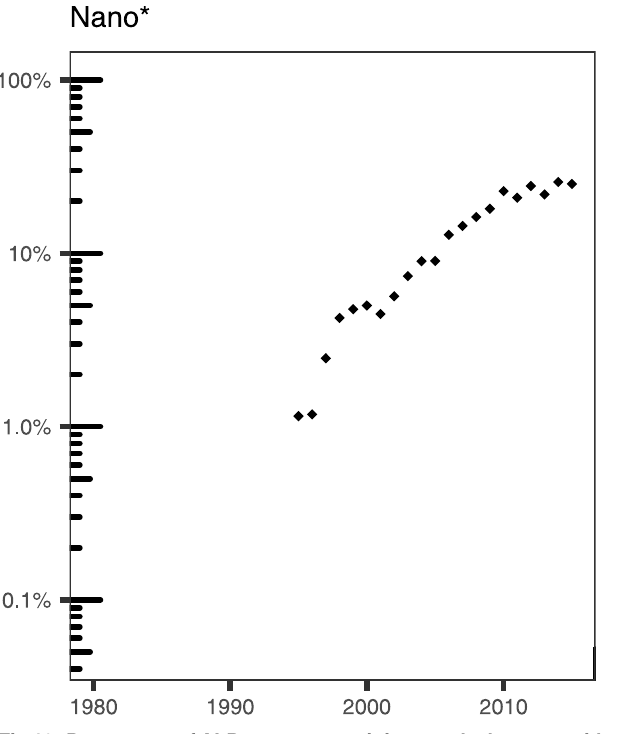
Fig 12. Percentage of ALD papers containing words that start with nano in their